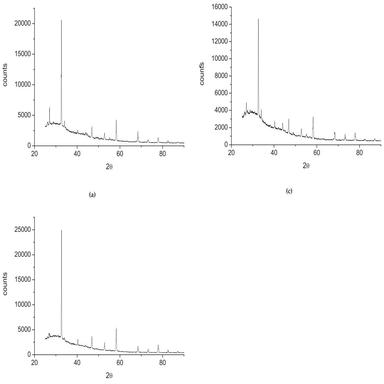
a: XRD diffraction pattern diagram of complex 1.b: XRD diagram of complex 2.c: XRD diagram of complex 3.